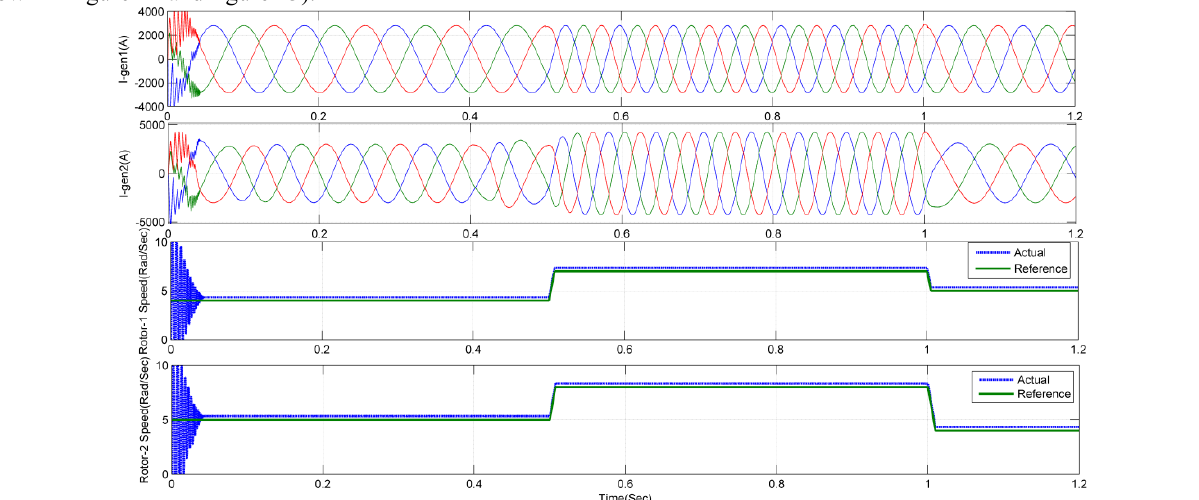
Figure 10. Generator side performance under grid fault